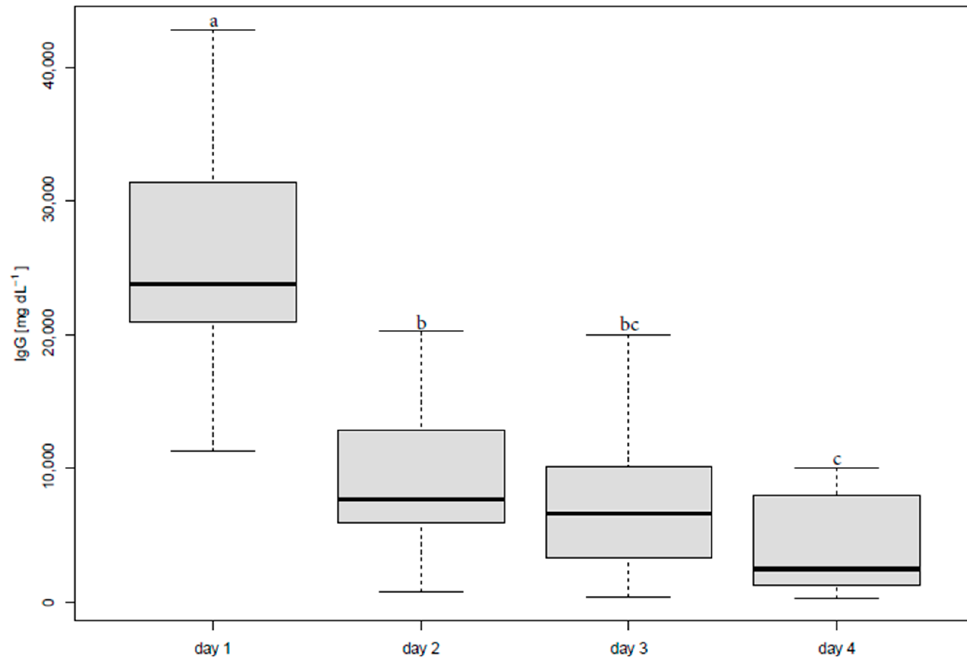
Figure 1. Boxplot of IgG concentrations in alpaca colostrum during four days after parturition, sig ‐ nificant differences between the days are marked by different indices. Different letters indicate sig ‐ nificant differences in values ( p < 0.05).